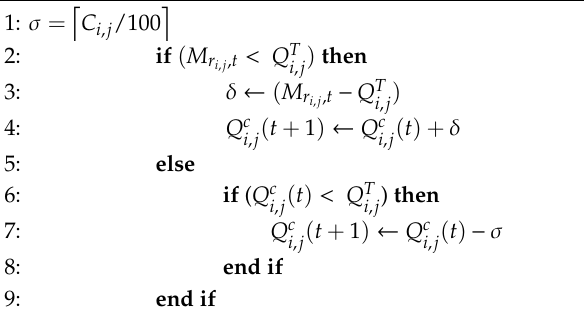
Algorithm 1. Congestion aware tra ffi c quota